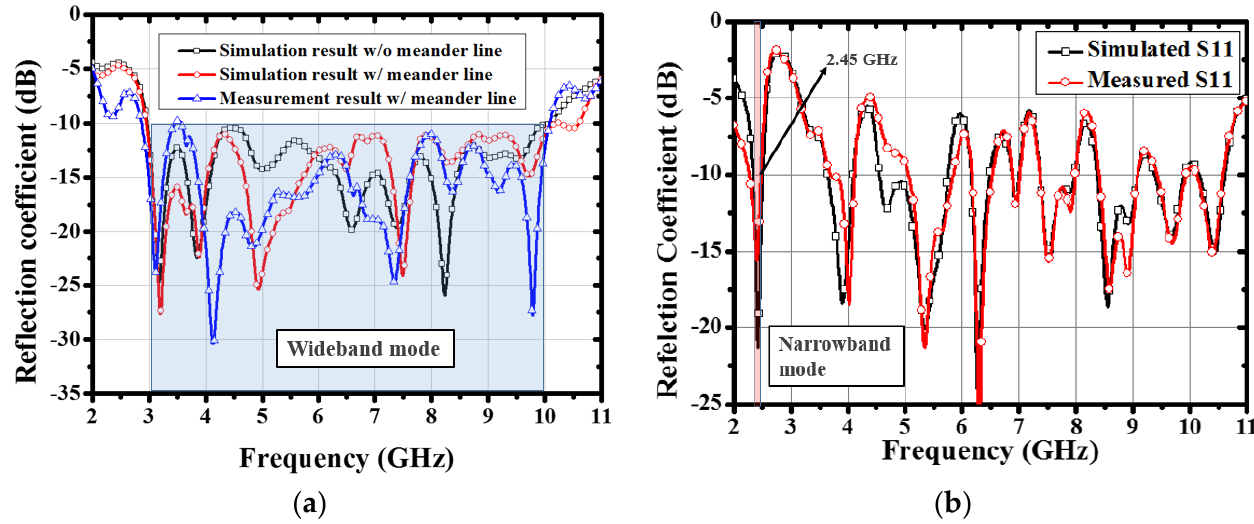
Figure 10. The simulated and measured reflection coefficients: ( a ) wideband mode for microwave imaging and ( b ) narrowband mode for microwave hyperthermia.